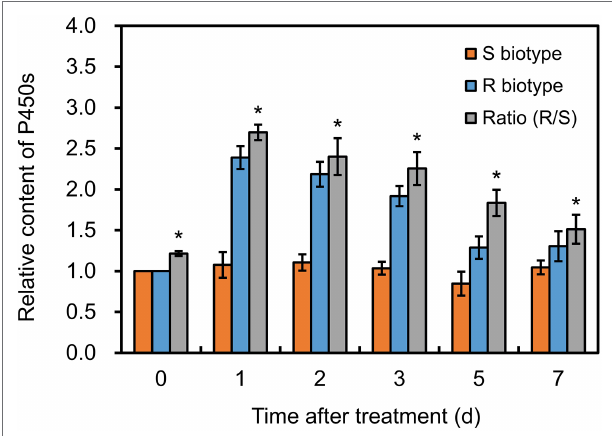
FIGURE 3 | Changes in cytochrome P450 contents in the S and R biotypes of Polypogon fugax after fenoxaprop- P -ethyl treatment. The difference in P450 contents was presented as ratio of the R relative to the S biotype. Data are the mean values ± SEM. * p <